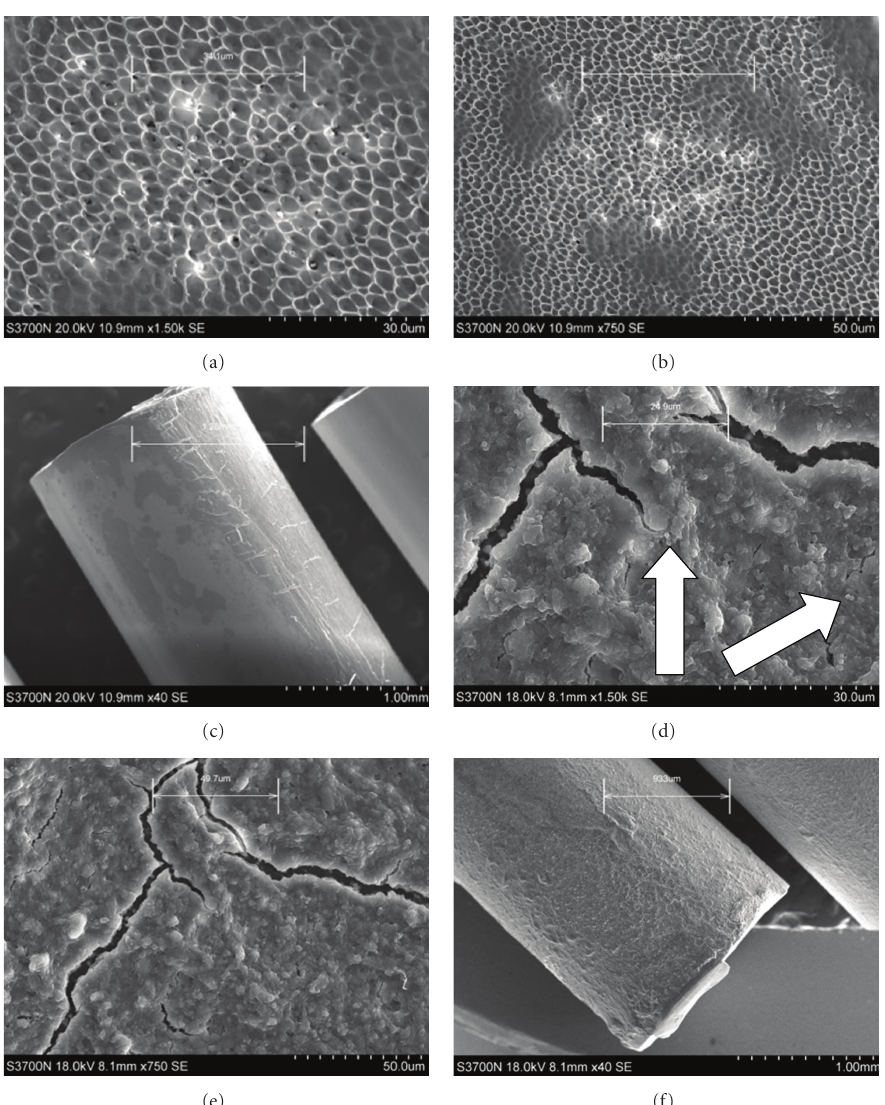
Figure 2: Representative SEM micrographs taken of test catheter 3 (segment 7) and control catheter 3 (segment 7) from animal 10 on day 21. (a) 1500x magnification of test catheter, (b) 750x magnification of test catheter, (c) 40x magnification of test catheter, (d) 1500x magnification of control catheter, (e) 750x magnification of control catheter, and (f) 40x magnification of control catheter. Note: the fissures seen in the biofilm in images D & E are artifacts from the SEM preparation process. Scale bars are presented on each image. Arrows point to isolated